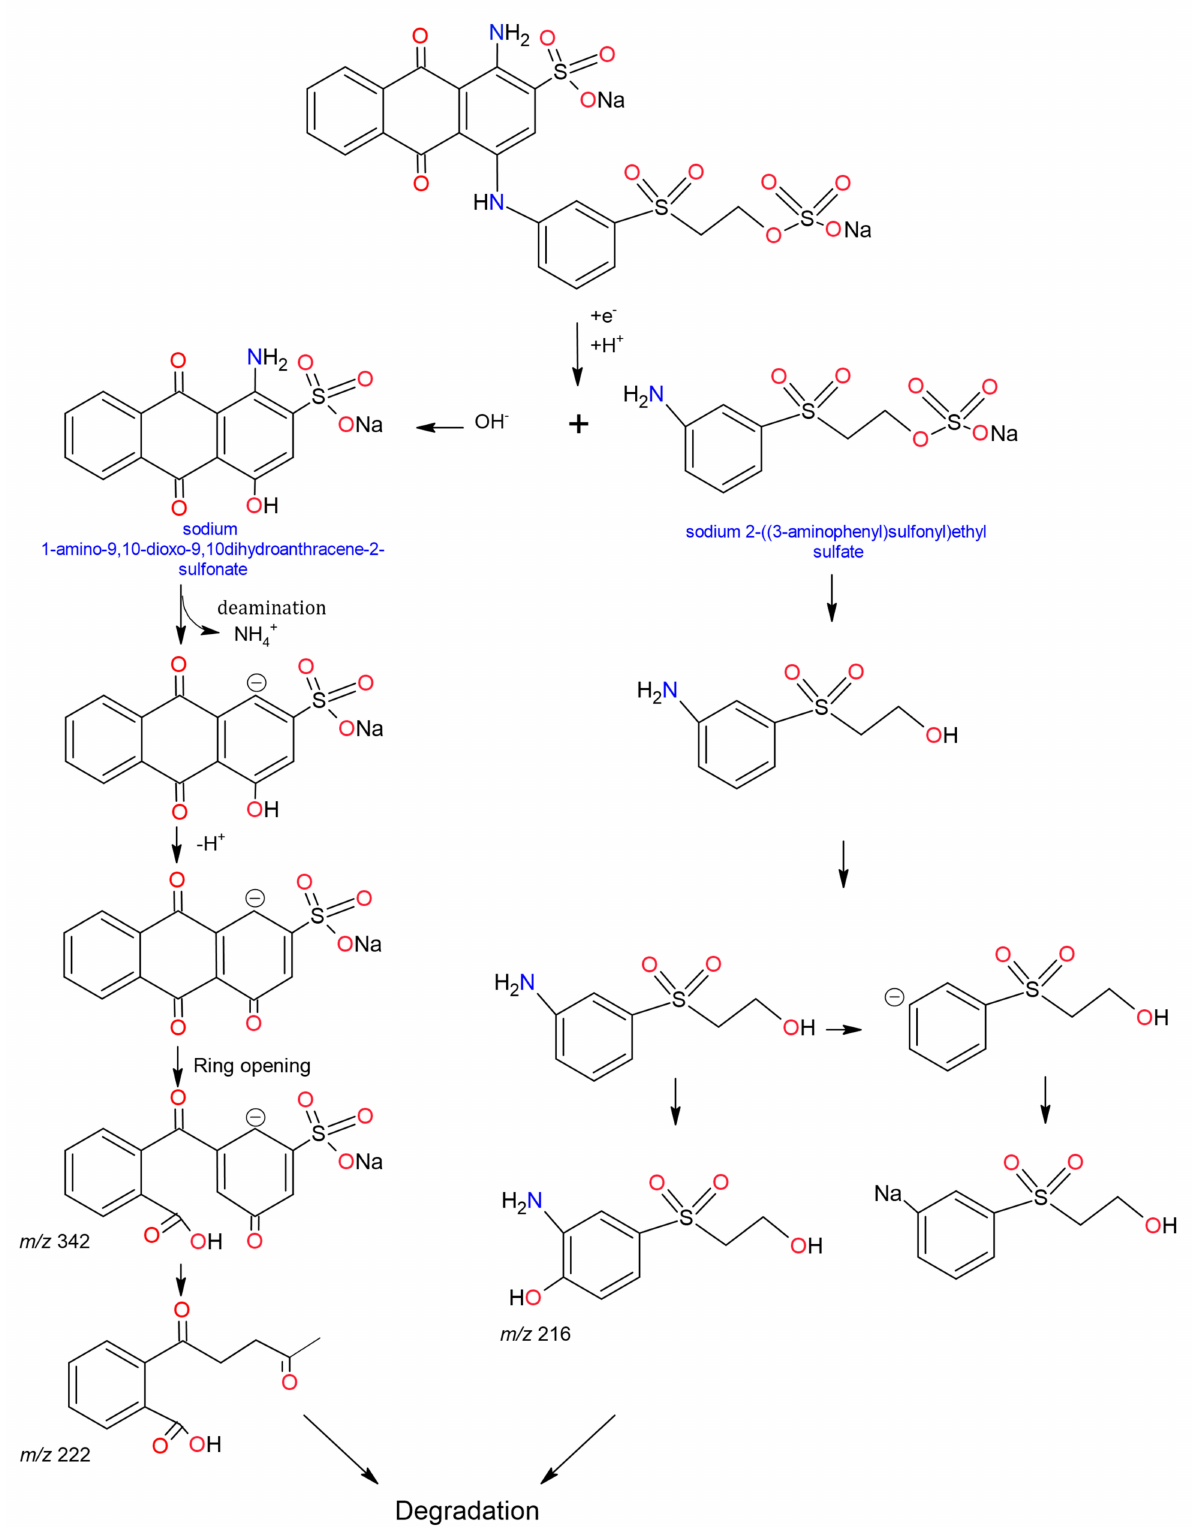
Figure 5. Route of degradation of the anthraquinone dye Remazol Brilliant Blue R (RBBR) by laccases. Adapted from